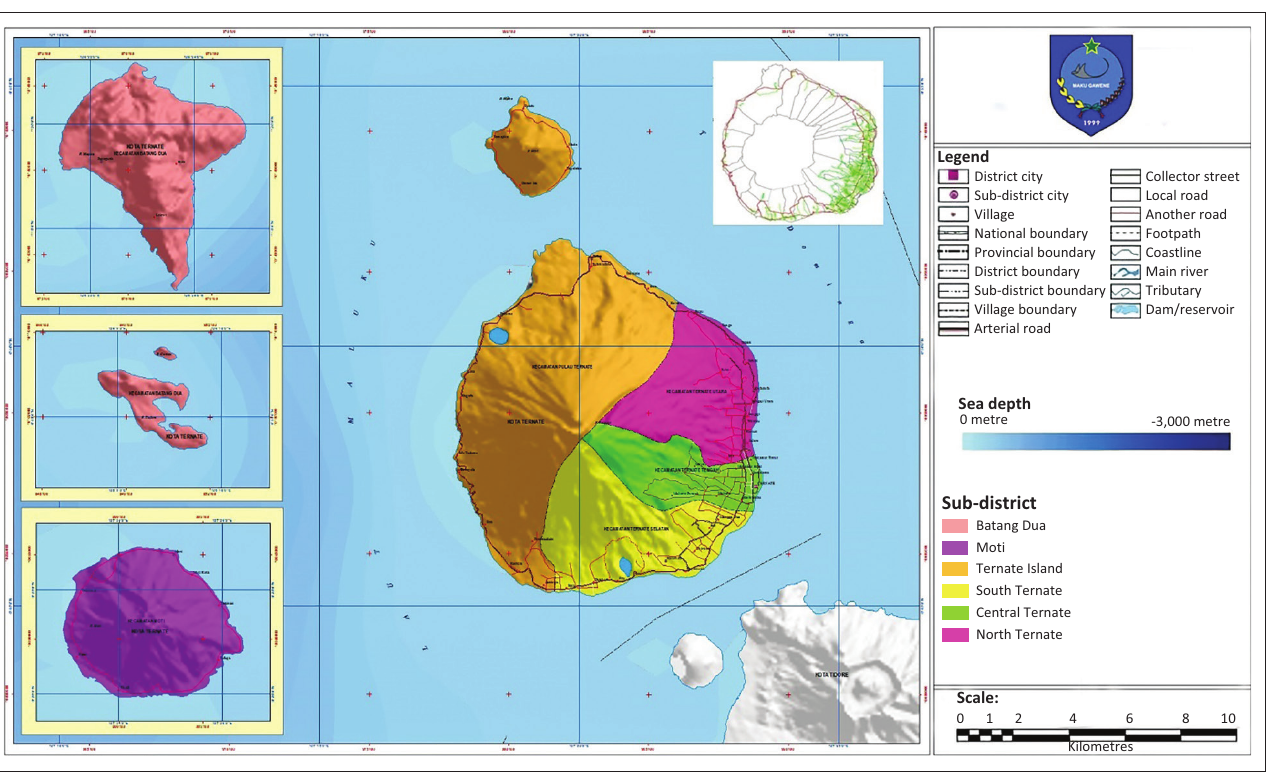
FIGURE 2 : Map of road network and zone of Ternate